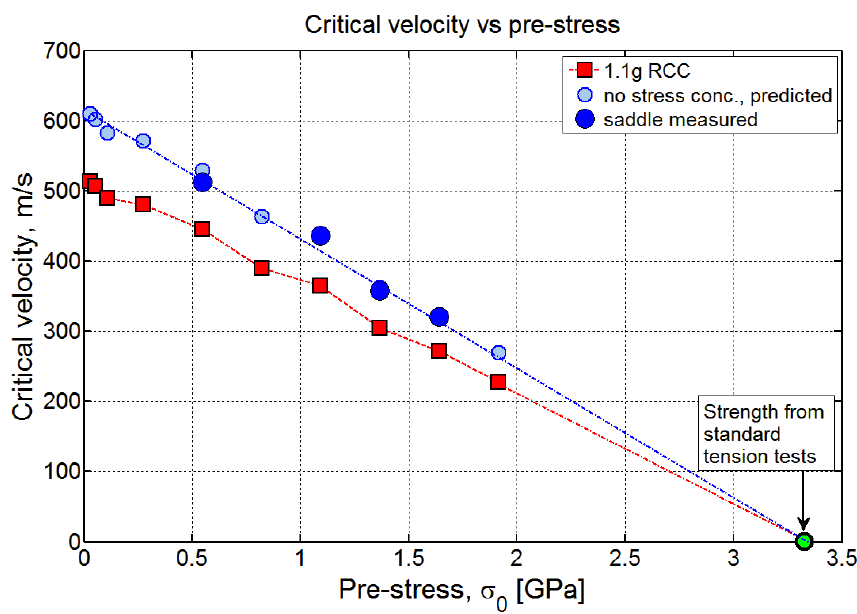
Figure 11. Comparison of experimental results from the right circular cylindrical (RCC) and saddle projectiles with the theoretical results on the stress concentration from wave collision under the flat nose of an RCC.